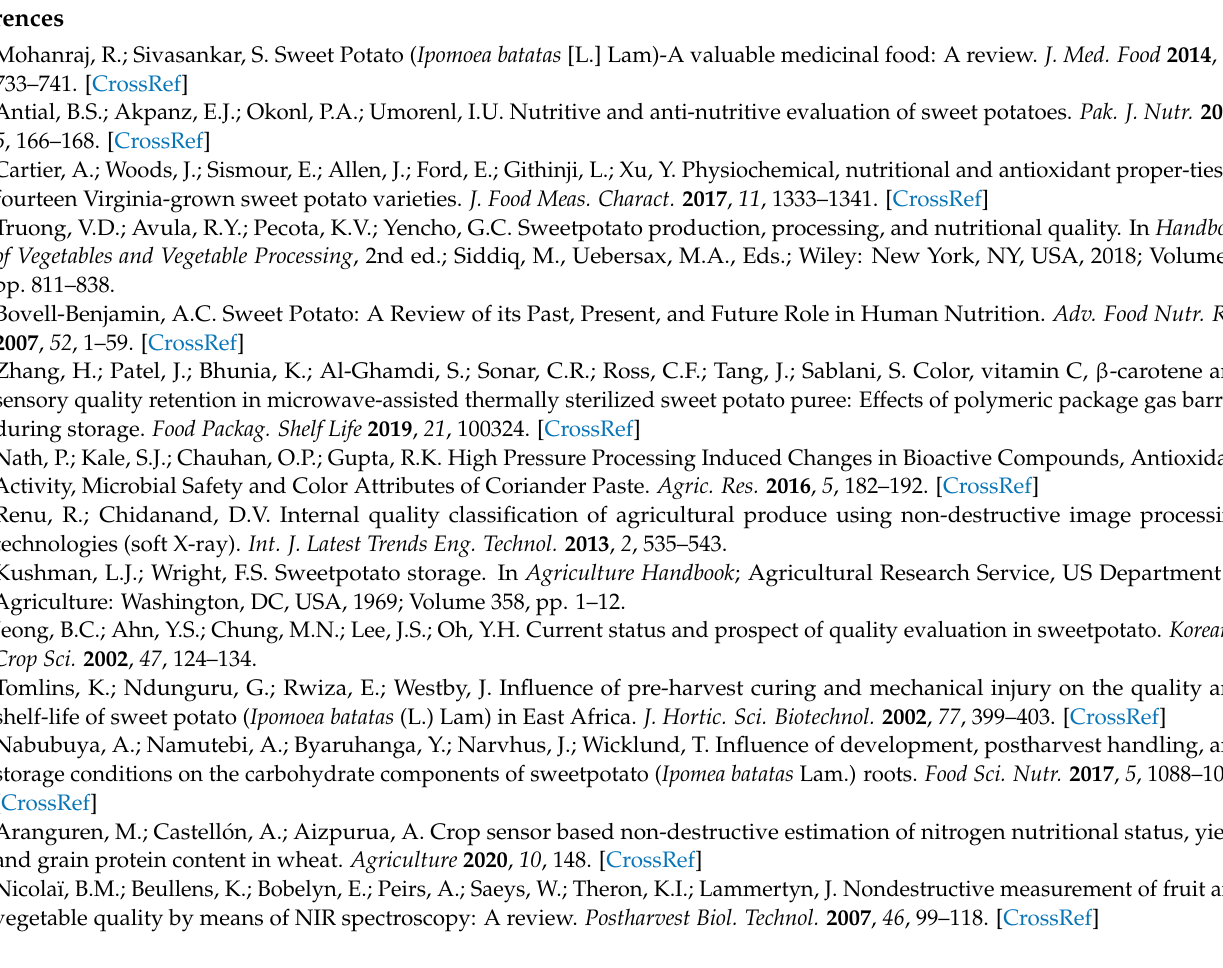
sweet potatoes; Figure S7: (A) Regression plot and (B) regression coefficient plot of PLS modeling about calibration and prediction set for multiplicative scattering correction (MSC) preprocessed spectrum and moisture content of sweet potatoes; Figure S8: (A) Regression plot and (B) regression coefficient plot of PLS modeling about calibration and prediction set for MSC preprocessed spectrum and starch content of sweet